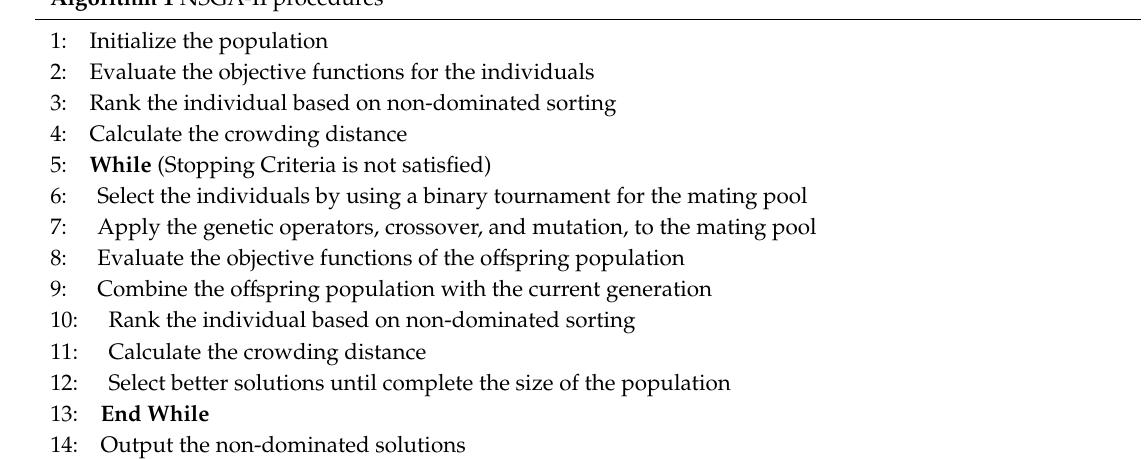
Algorithm 1 NSGA-II